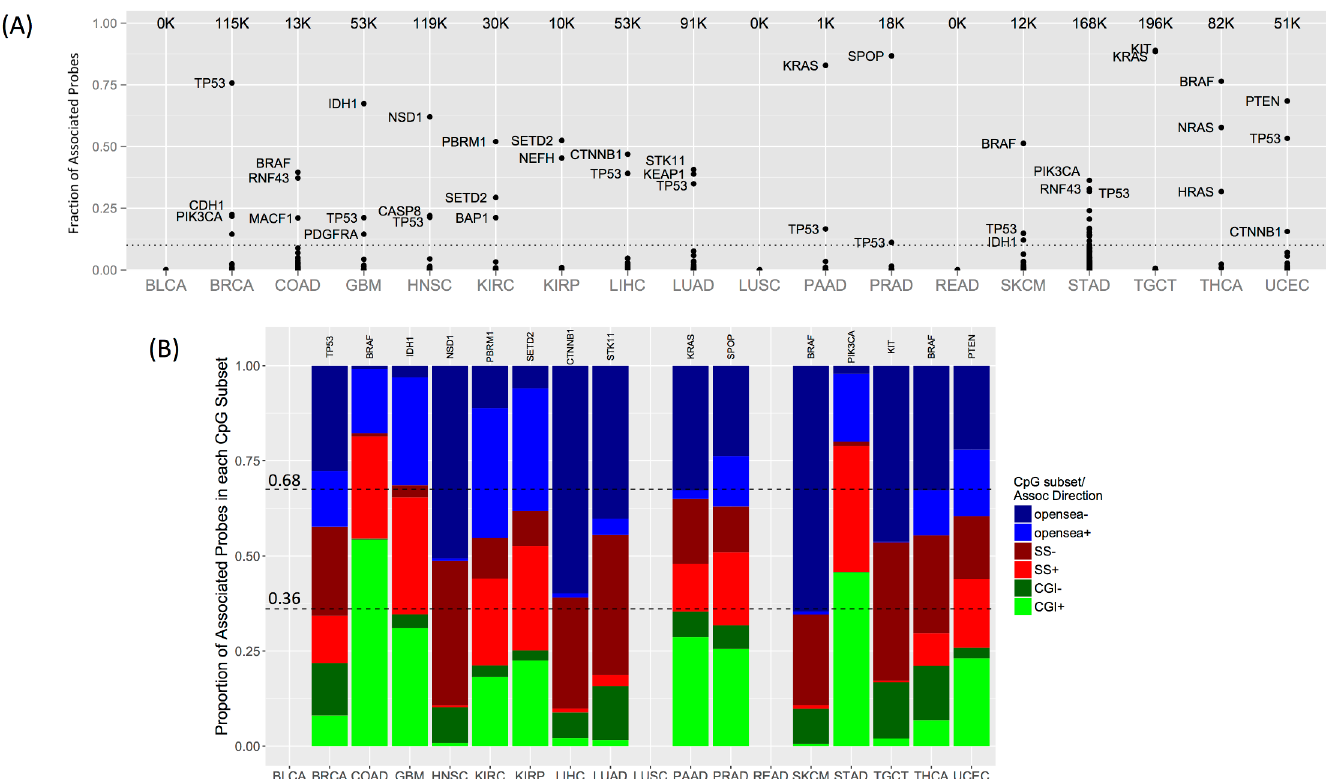
Fig 2. Driver gene–methylation associations and CpG subsets. (A) The total numberof probes associated with any driver gene is shown for each cancer type ( top of each column ).Each point represents the fraction of corresponding probes associatedwith a driver gene (y-axis). Names are shown for each of the top three driver genesif they account for more than 10% of total probes ( dotted line ). See Table 1 for cancer type abbreviations. (B) Driver geneswith the most probe associationsin each cancer type ( genenames in panel ).The bar plots show the proportionof associatedprobes in each of the three CpG subsets [CpG islands (CGIs), shores and shelves (SSs), or open sea], stratified by the directionof association(+/-). Dashedlines indicatethe divisionsexpectedif associations were proportionally distributed. No probes were associatedwith driver genes in BLCA, LUSC, and READ.